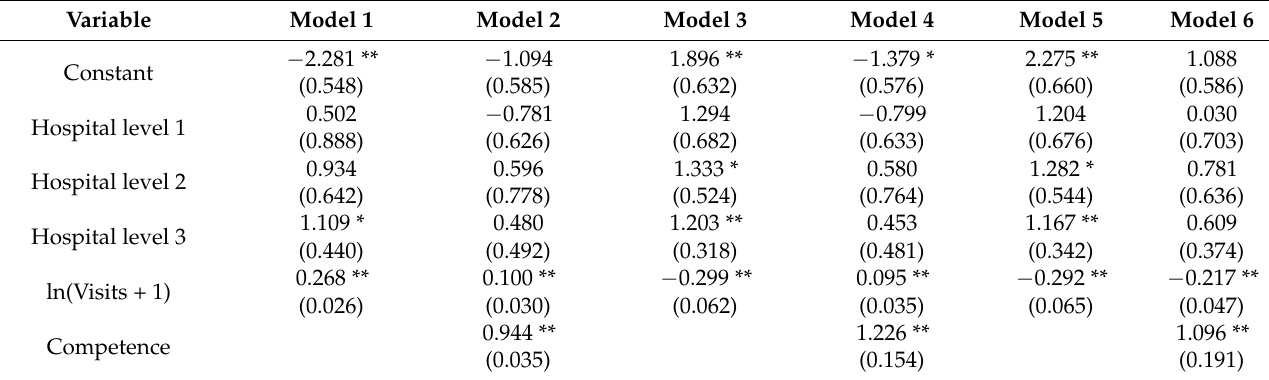
Table A2. Parameter estimates of robustness check